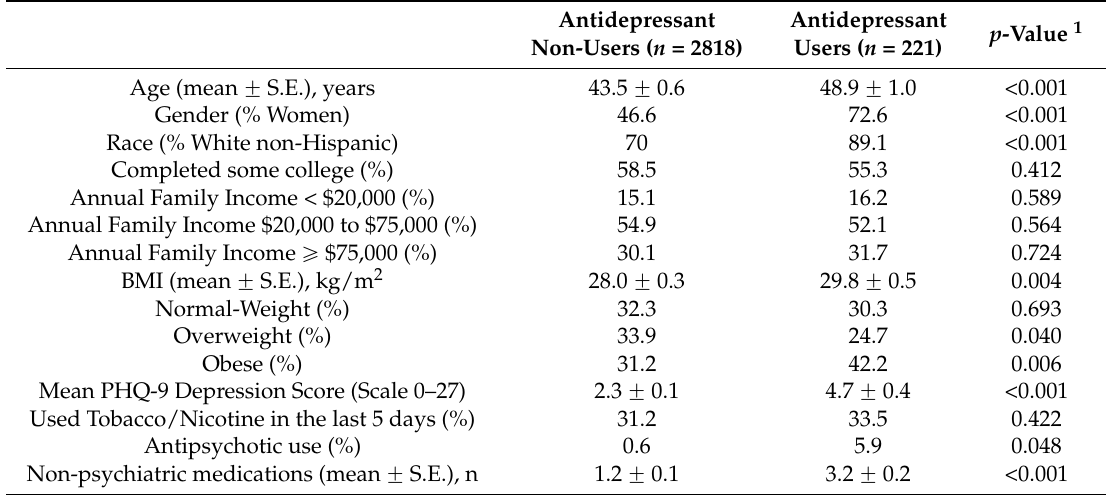
Table 1. Patient Demographics by Antidepressant use from the 2005–2006 National Health and Nutrition Examination Survey (NHANES).